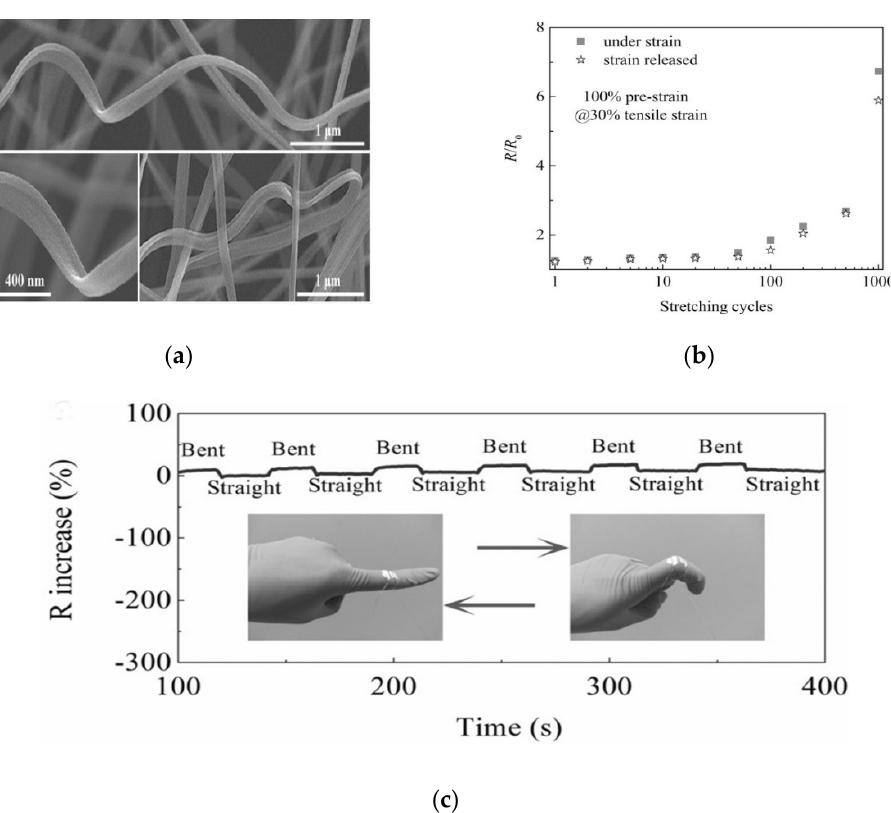
Figure 5. ( a ) SEM images of pre-strained SnO 2 nanowebs, showing spring- (upper and lower left) and wave-like geometries (lower right); ( b ) R/R0 of the SnO 2 nanobelt network on 100% pre-strained PDMS as a function of stretching cycles; ( c ) Repeated finger bending test of wearable SnO 2 photodetectors. Reproduced with permission from Ref. [79]; 2015, Wiley.